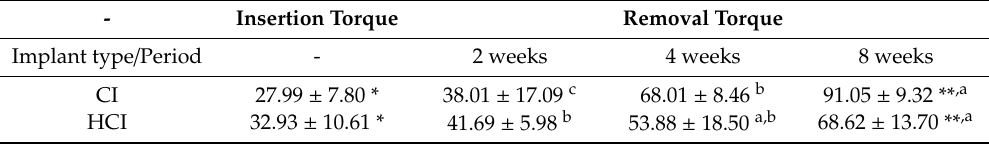
Table 1. Data on the mean and standard deviation for the insertion and removal torque of all groups. -